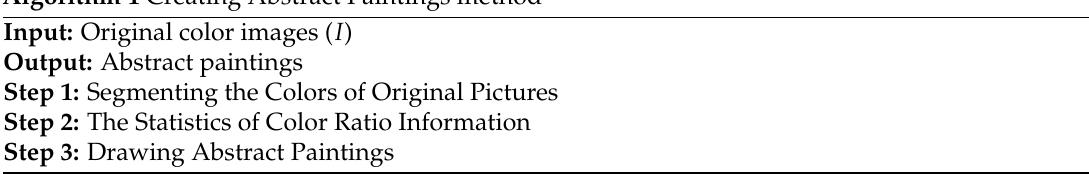
Algorithm 1 Creating Abstract Paintings method